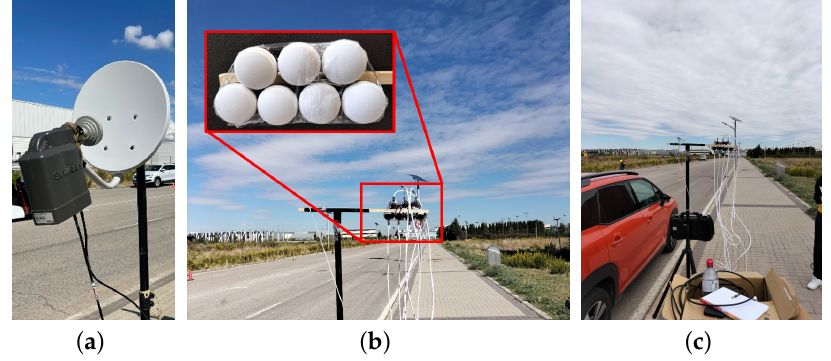
Figure 11. DVB-S IDEPAR antennas systems and collaborative vehicle in the considered scenario. ( a ) Reference antenna. ( b ) Surveillance antenna array. ( c ) Collaborative vehicle.